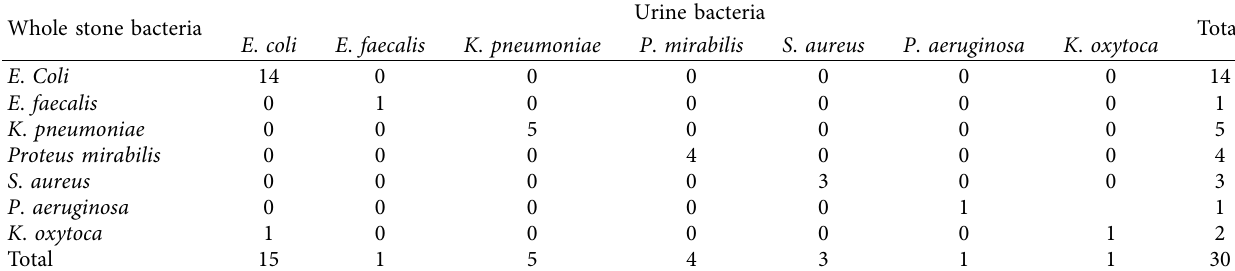
Table 4: Similarity in urine and stone matrices (whole)